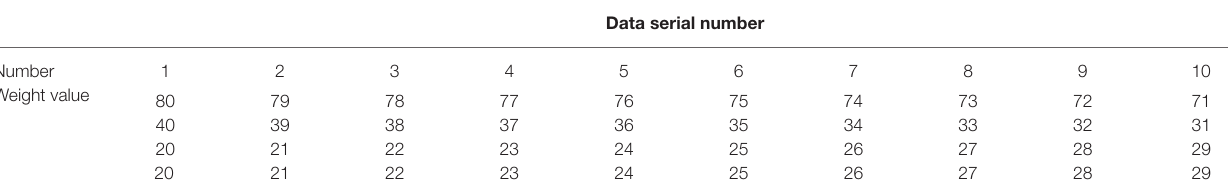
TABLE 3 | Weight setting values for convergence speed